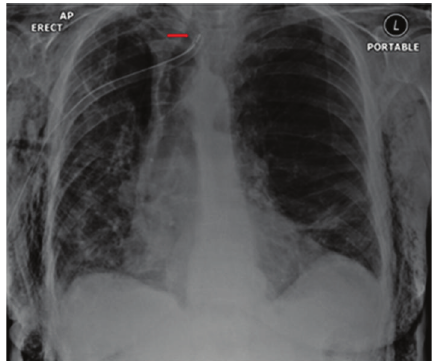
Figure 19: A CXR showing an inappropriately placed chest drain. Note the extensive surgical emphysema.